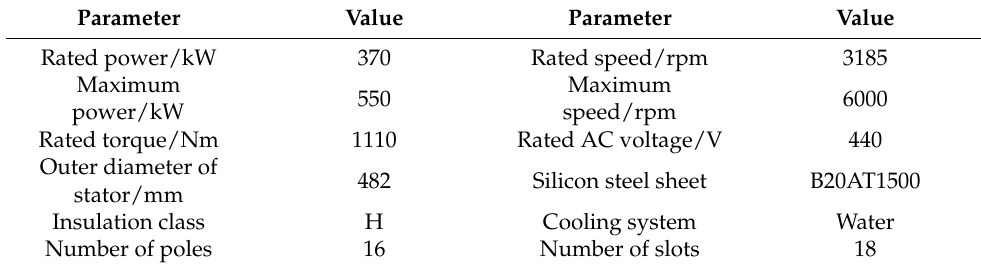
Table 1. The main parameters of the 370 kW